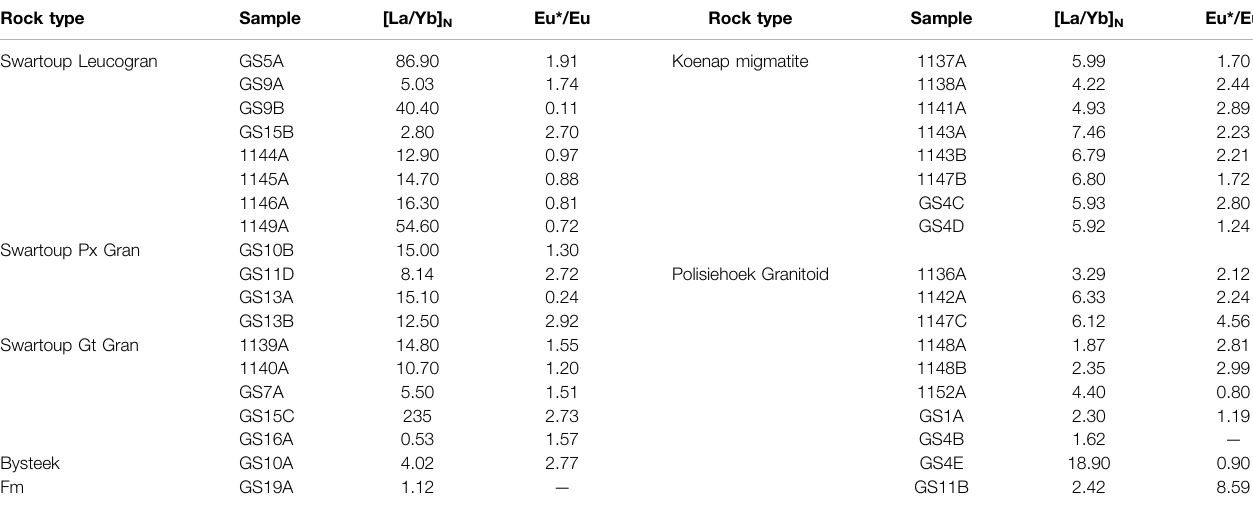
TABLE 1 | [La/Yb] N ratios and Eu*/Eu